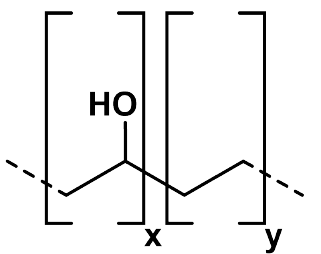
Figure 3. Schematic chemical formula of an ONYX-type embolic polymer [26].